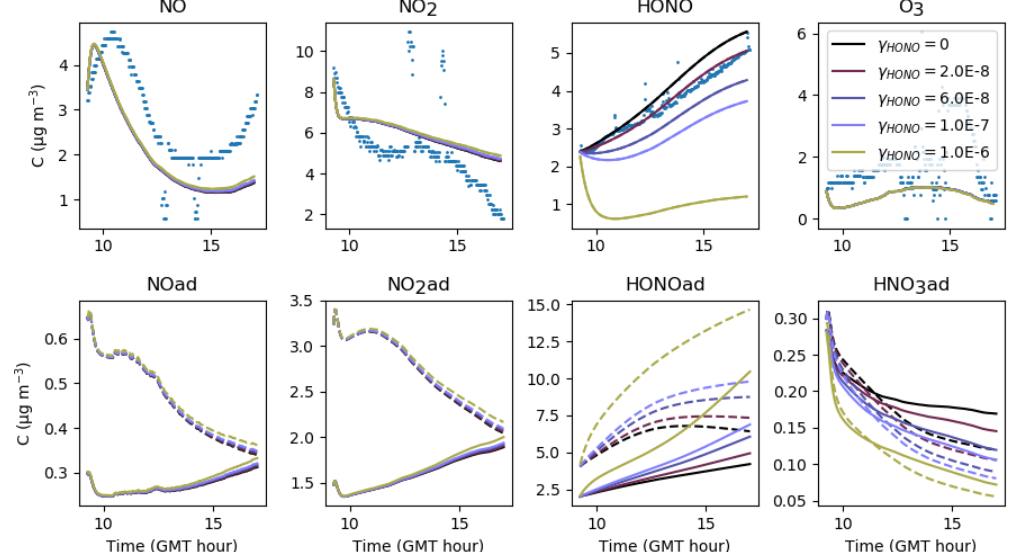
Figure 20. Gas-phase and adsorbed inorganic compounds simulated for different γ HONO . The blue dots denote the experimental measure- ments (Experiment 3). The solid lines represent the concentrations in the sunlit box and the dashed lines the concentrations in the shaded